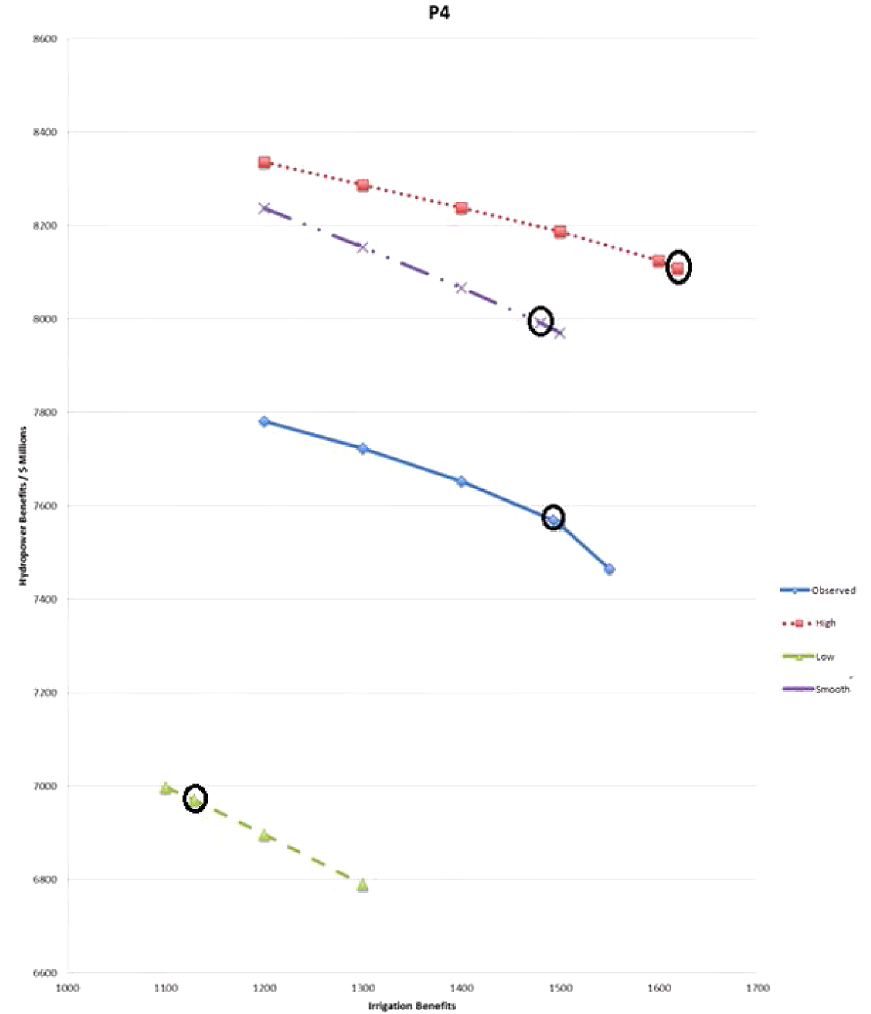
Figure 7. Results of SHOM simulations in which the agricultural benefits are phrased as constraints, and the hydropower benefits are calculated for a specific agricultural benefit. The circles highlight the optimal values for each